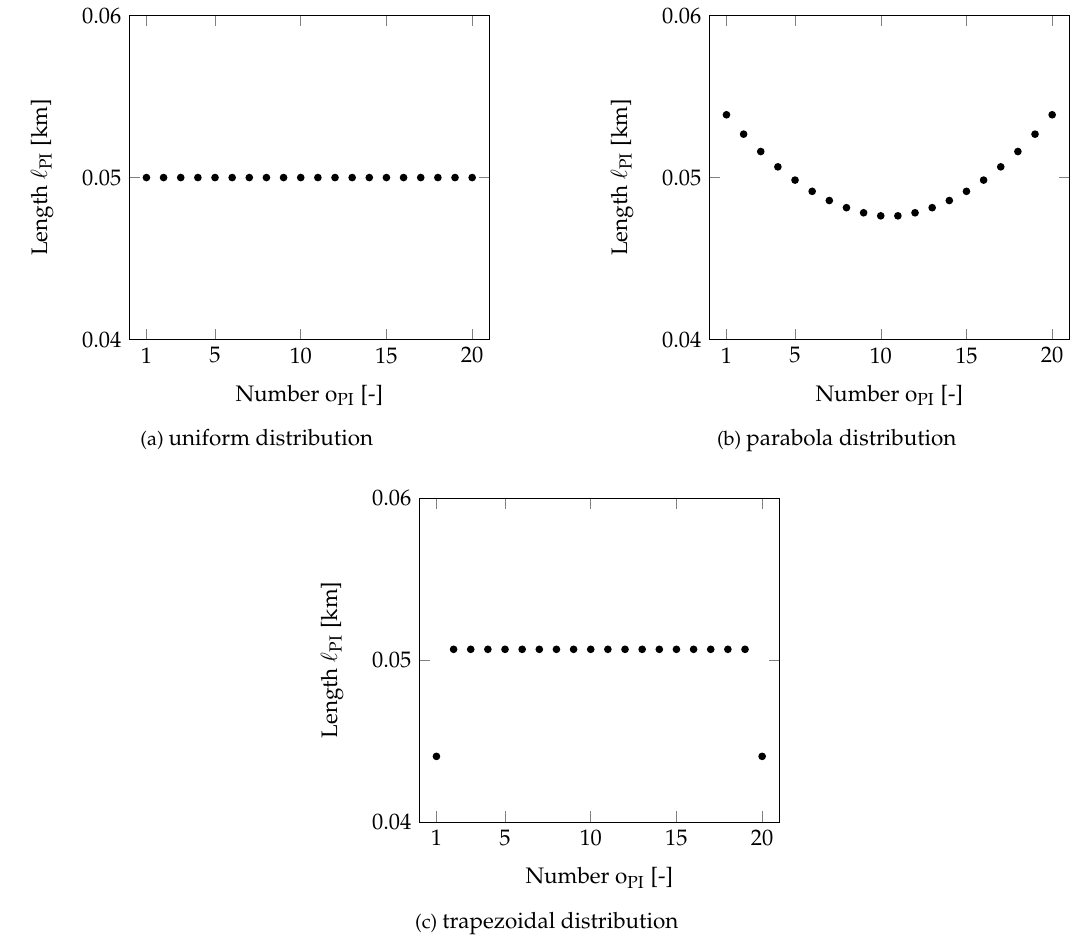
Figure 6. Length distribution profiles of